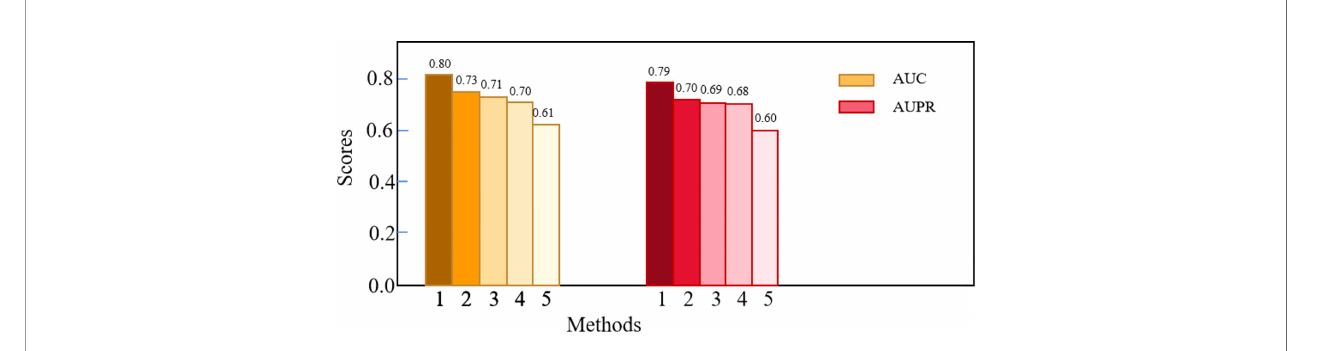
FIGURE 2 | The comparison results of Deep-LC and other four methods.